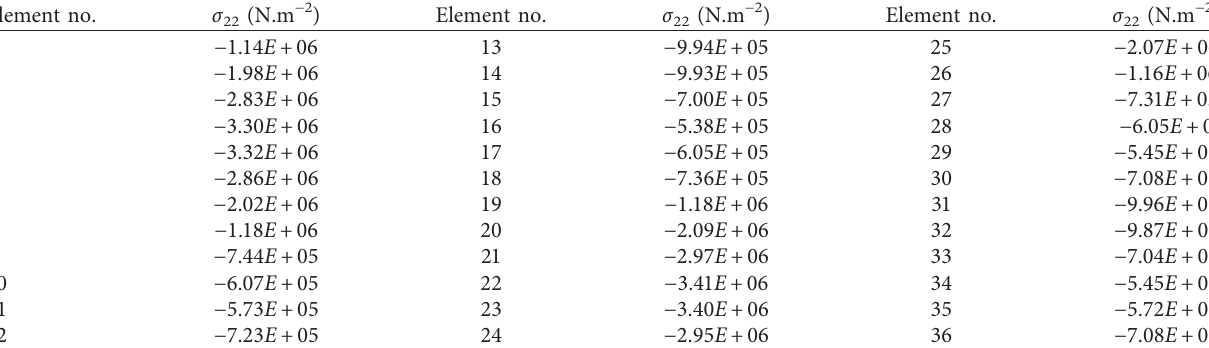
Table 6: The calculation of jacking force based on the numerical simulation results (for case A1, driving distance 73.5m, grouting pressure 0.13MPa).